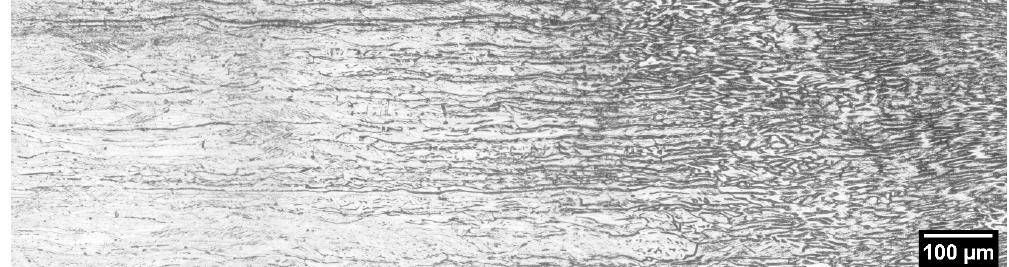
Figure 6. Transversal micrography at the weld bead (right)/HAZ (left) interface after 50% cold rolling.